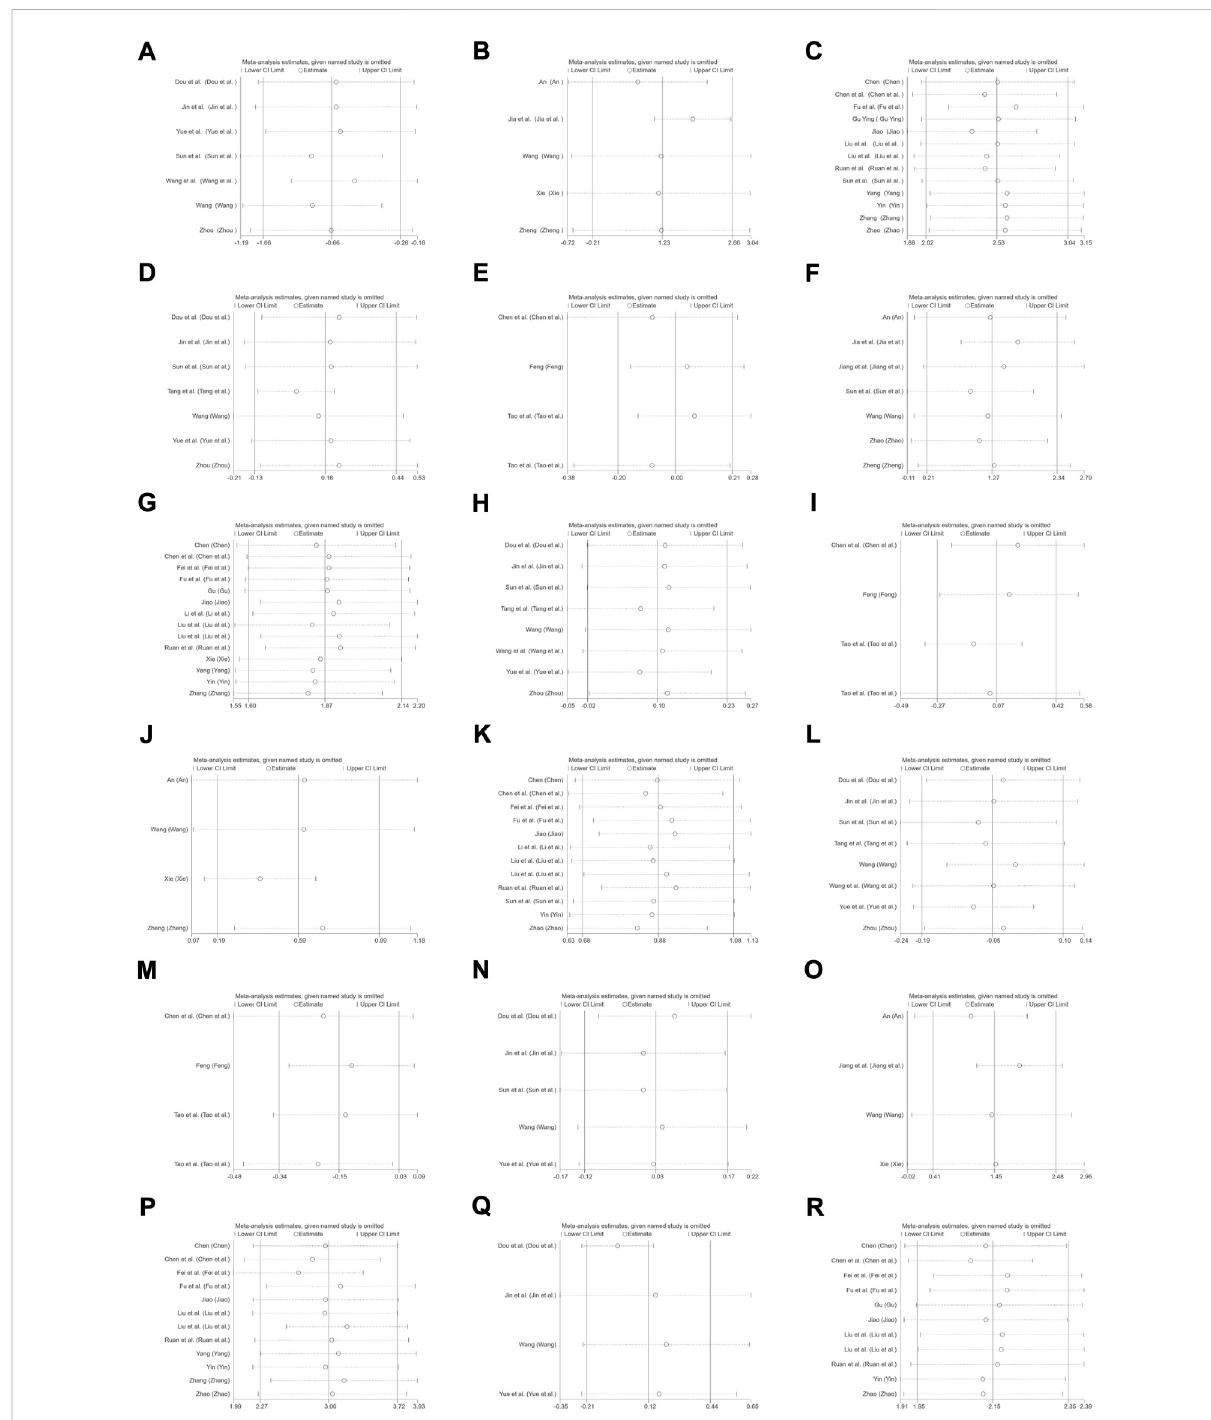
FIGURE 9 Sensitivity analysis plot. (A) Red blood cell count in children (subgroup 1); (B) Red blood cell count in pregnant women (subgroup 1); (C) Red bloodcellcountinpregnantwomen(subgroup2); (D) Hblevels inchildren(subgroup1); (E) Hblevels inadults(subgroup1); (F) Hblevels inpregnant women (subgroup1); (G) Hblevels inpregnant women(subgroup2); (H) MCVlevels inchildren(subgroup1); (I) MCV levelsinadults(subgroup1); (J) MCVlevels inpregnantwomen (subgroup 1); (K) MCVlevels inpregnant women(subgroup2); (L) MCH levels inchildren(subgroup1); (M) MCH levels in adults (subgroup 1); (N) SI levels in children (subgroup 1); (O) SI levels in pregnant women (subgroup 1); (P) SI levels in pregnant women (subgroup 2); (Q) TIBC levels in children (subgroup 1); (R) TSAT levels in pregnant women (subgroup